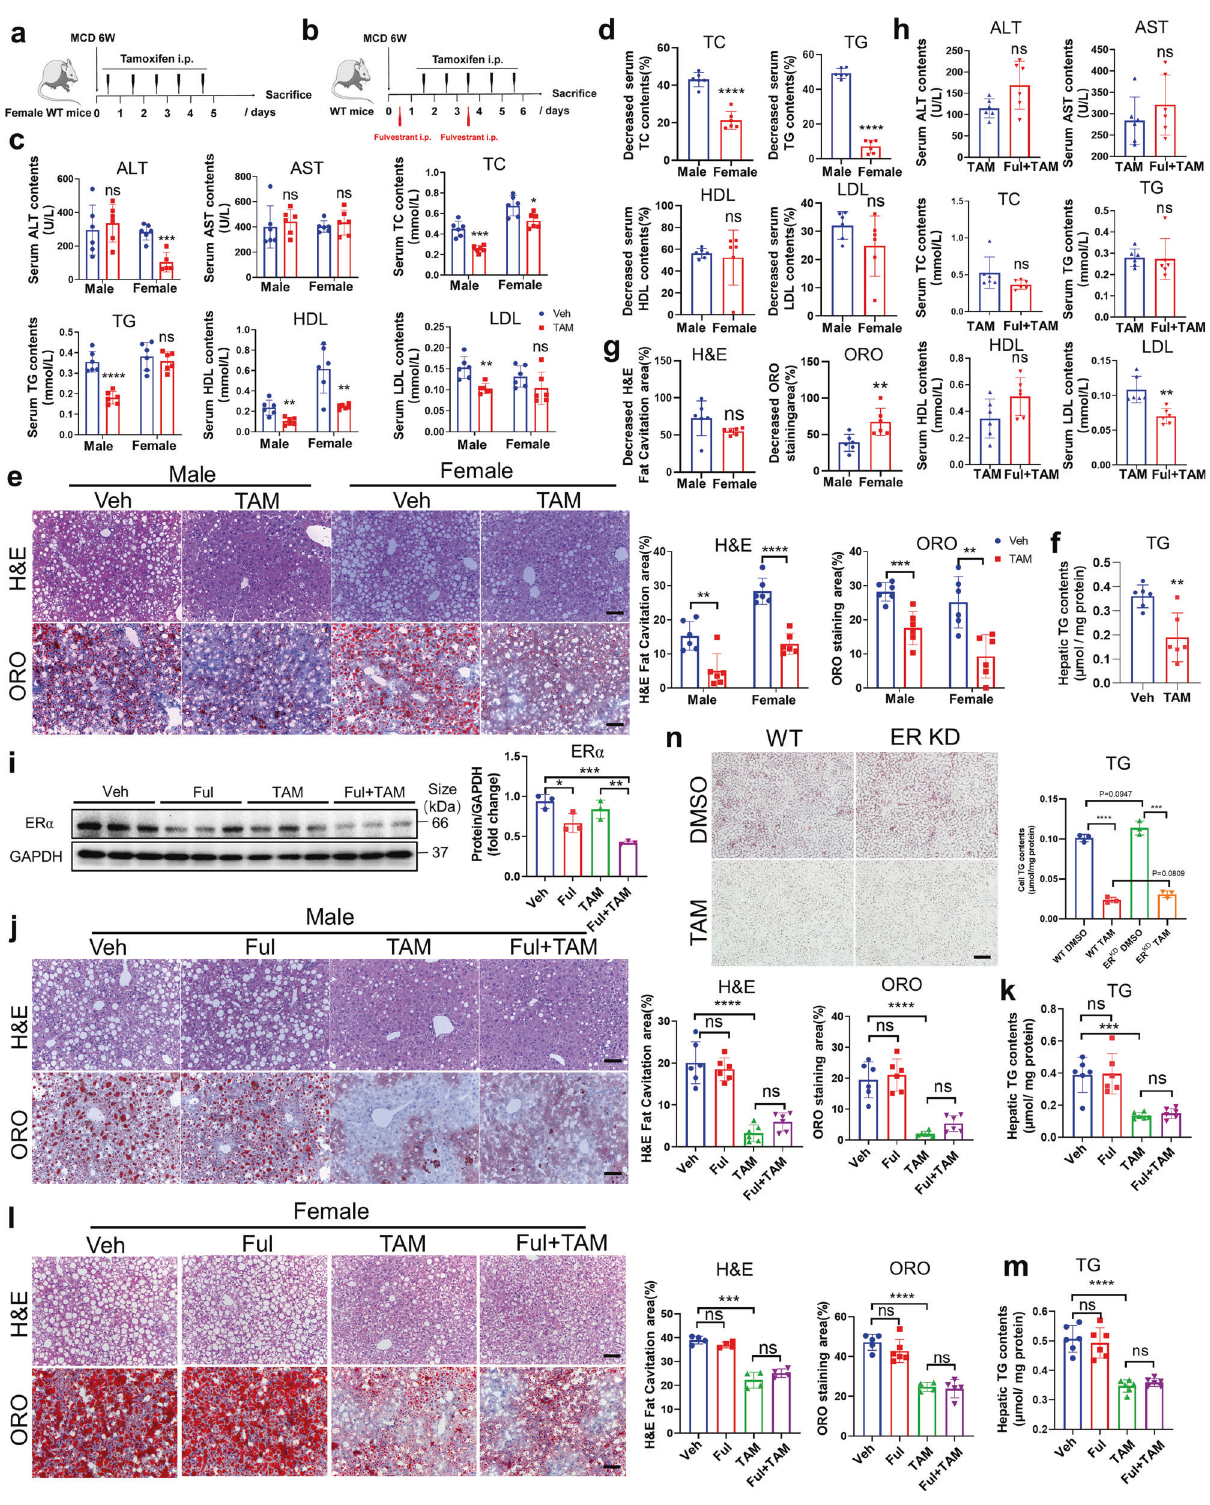
Occasionally, during the induction of CreER recombinase activity by tamoxifen, we found that tamoxifen diminished serum lipid contents and inhibited hepatic lipid accumulation simulta- neously in mice. This phenomenon arouses our great interest. We conjectured if tamoxifen could treat NAFLD or NASH in mice.